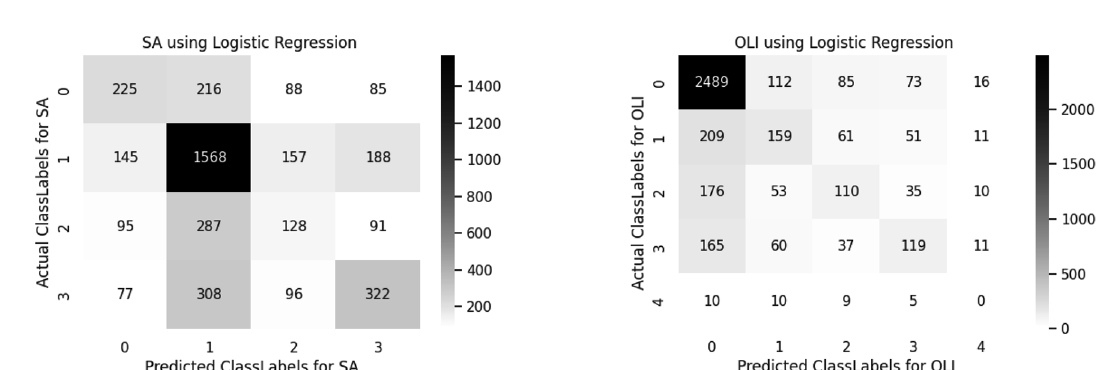
Figure 4. Confusion matrix of logistic regression for sentiment analysis and offensive language